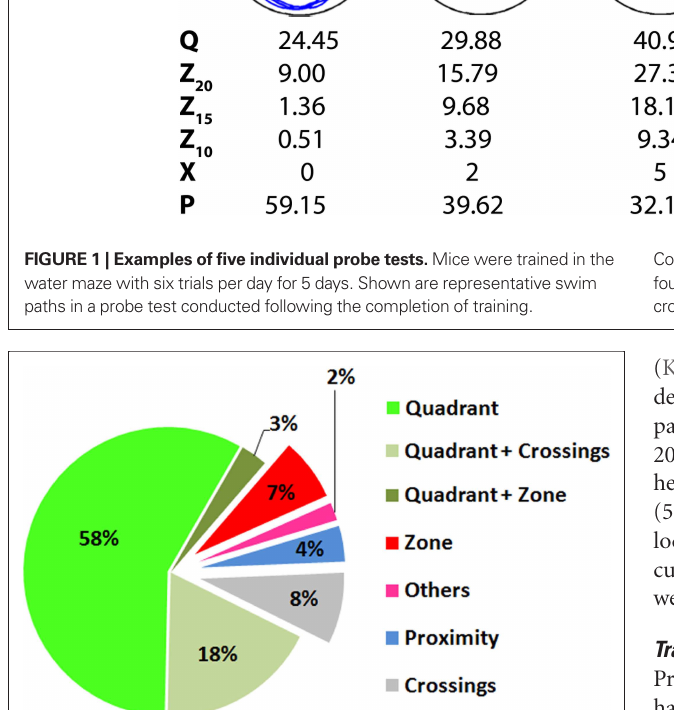
FIGURE 2 | Popularity of different probe test measures. To assess the relative frequency with which different probe test measures are used, a PubMed search (http://www.ncbi.nlm.nih.gov/sites/entrez) using the terms [(rat OR mouse) AND water maze] was conducted for the period 2004–2006. Out of a total of 205 papers surveyed, 135 assessed spatial learning/memory using a probe test. The pie chart shows the relative frequency that different measures (or combinations of measures) were used to quantify probe test performance in these